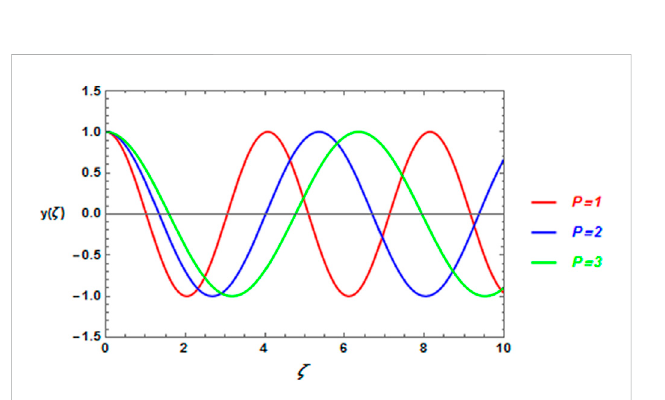
FIGURE 5 In fl uence of the parameter ω 0 on the periodic solution Eq. 32.